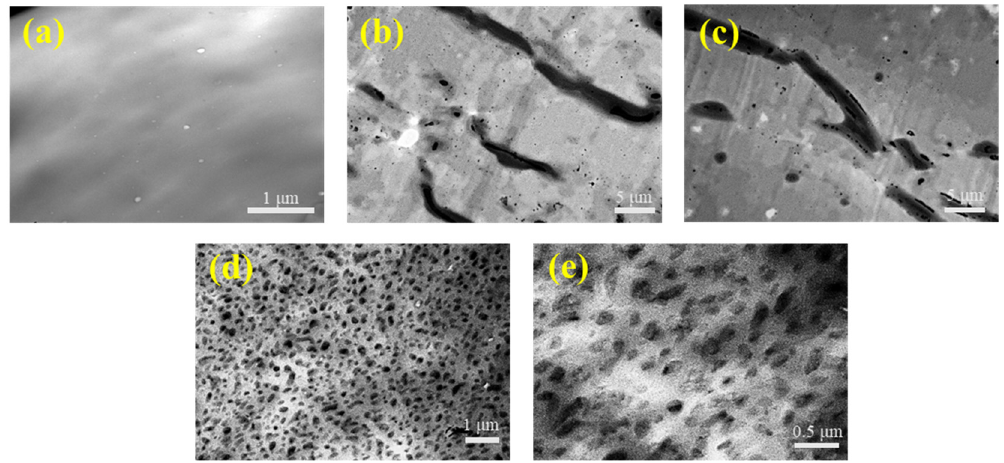
Figure 1. TEM image of ultrathin cross sections of films: ( a ) without using PVP; ( b ) using 5% of PVPK30; ( c ) using 10% of PVPK30; ( d ) using 15% of PVPK30; and ( e ) using 20% of PVPK30.